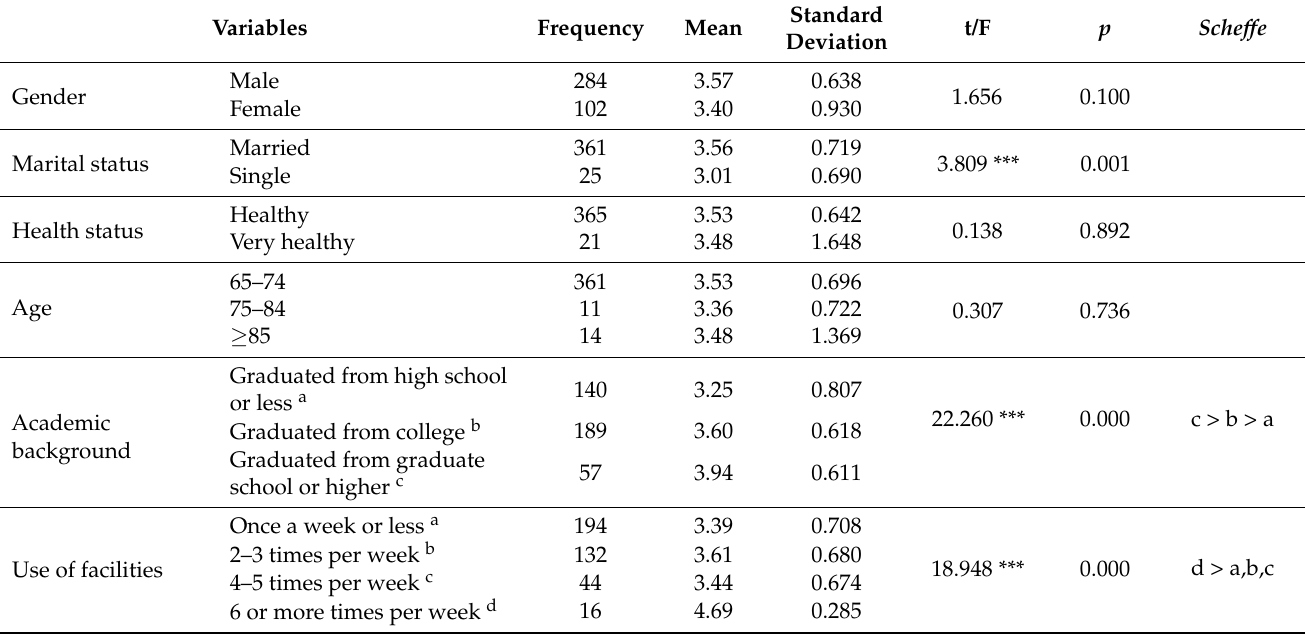
Table 4. Differences in mechanistic service factors according to demographic